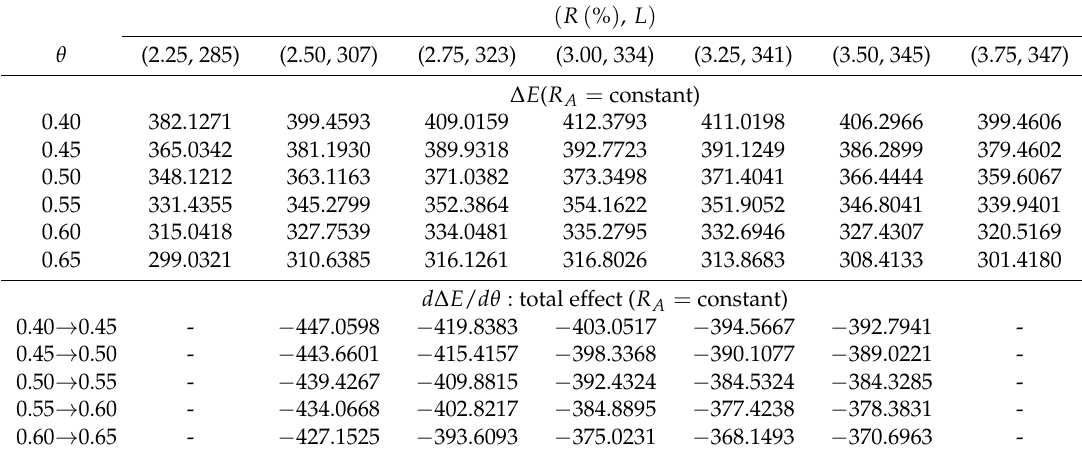
Table 7. Responsiveness of efficiency gain from CEO overconfidence to buying distressed assets when liability-side interest margin is considered, Equation (21) 1